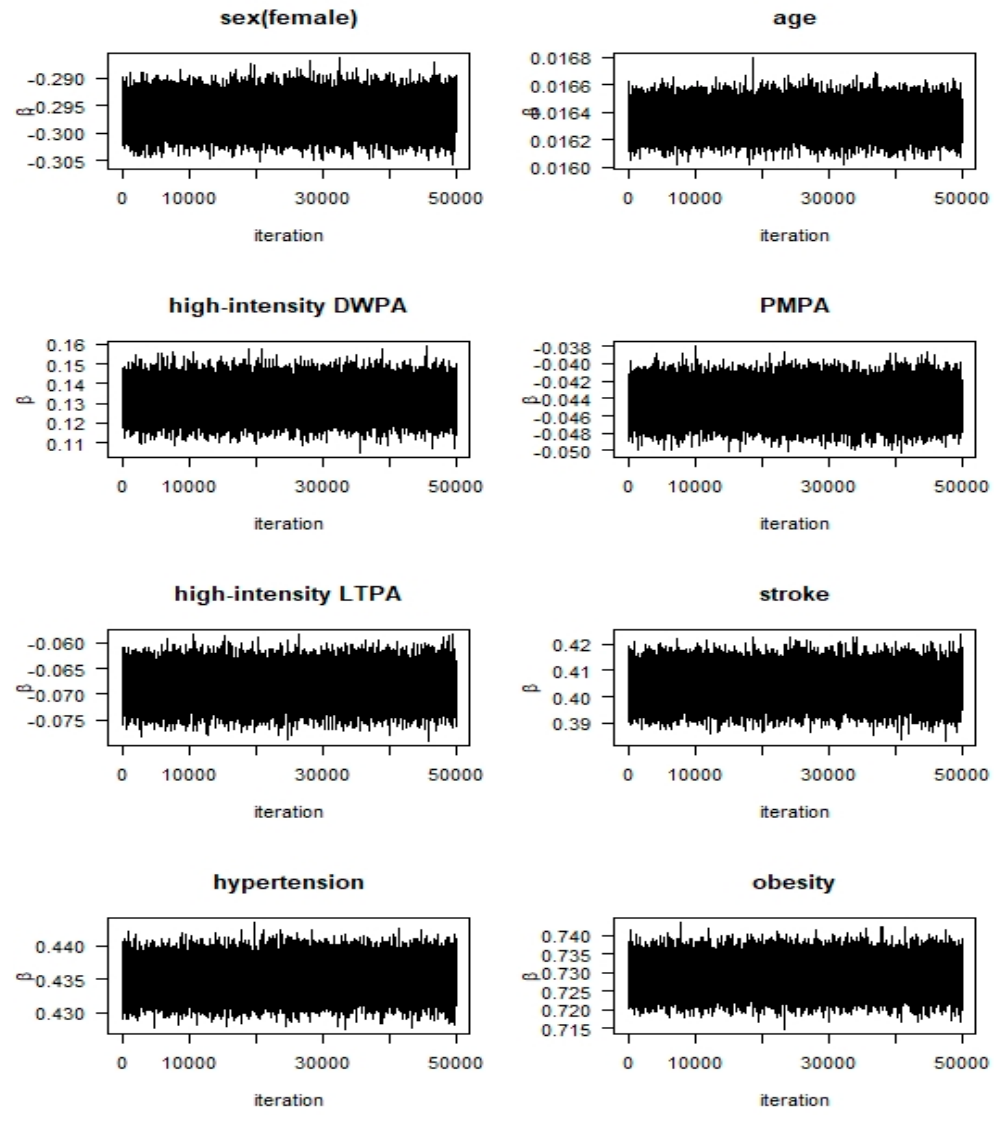
Figure 1. Path diagrams for variables. Table 3. Relative frequency of each FBG category.